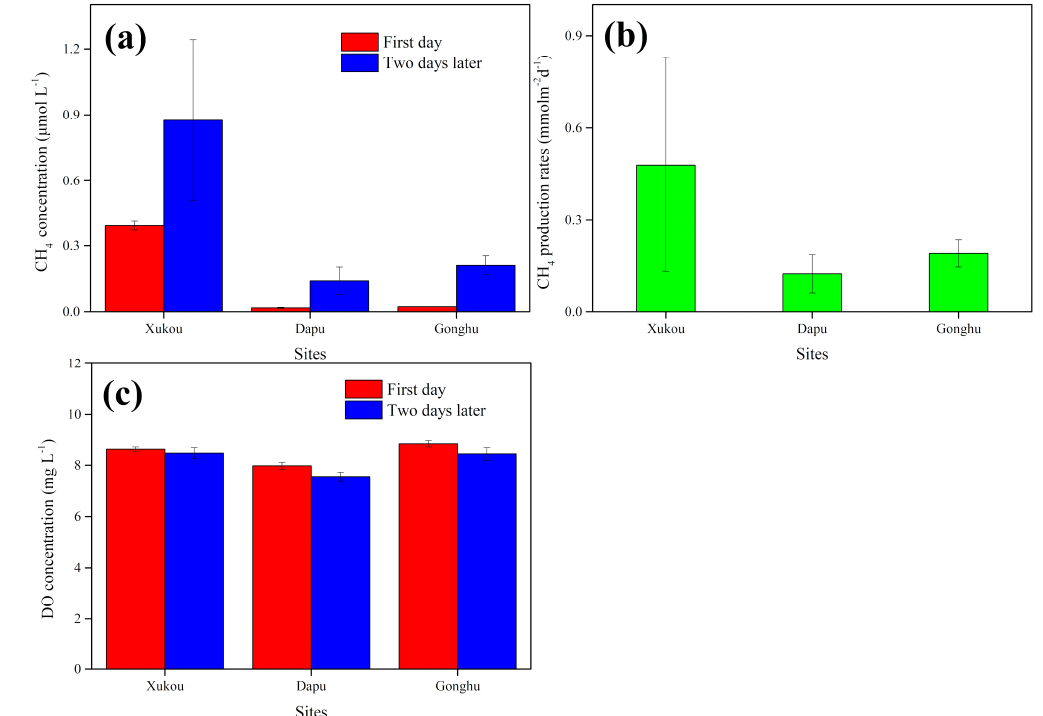
Figure 6. ( a ) The concentration of dissolved CH 4 in the incubation experiment, where red means before incubation and blue means after incubation; ( b ) CH 4 production rates of sediments; ( c ) the DO concentrations in the incubation experiment.